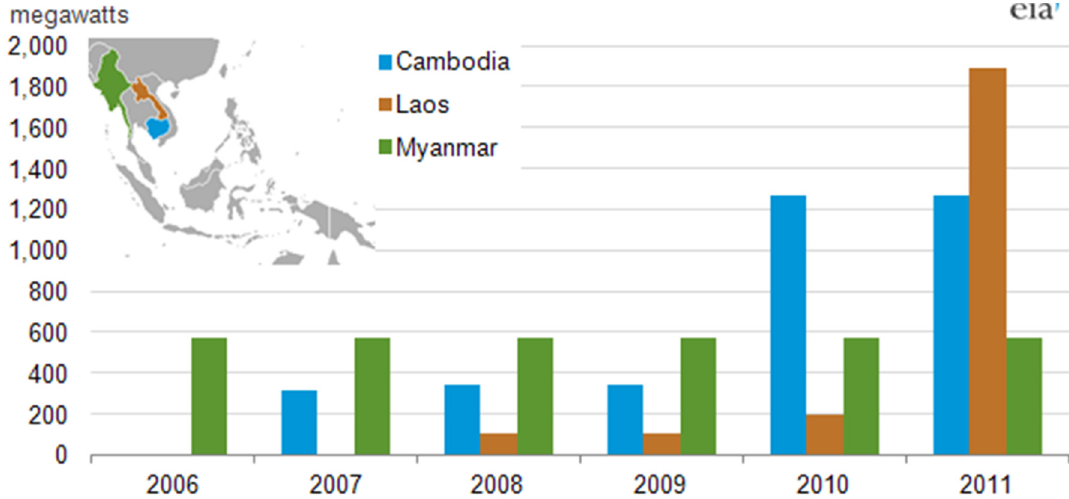
Figure 1. Cumulative hydroelectric capacity additions financed by China (2006–2011) (Source EIA, 2013